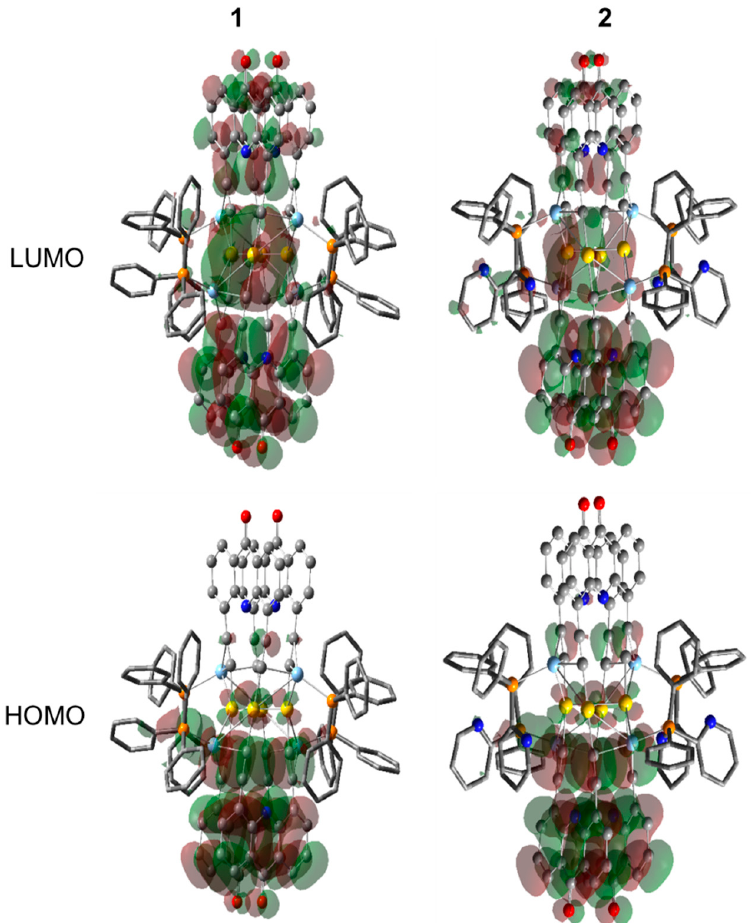
Figure 3. Plots of the HOMO and LUMO in triplet state (isovalue = 0.012) for Au 4 Ag 4 Cluster Complexes 1 and 2 by TD-DFT method at the PBE1PBE-GD3 level.